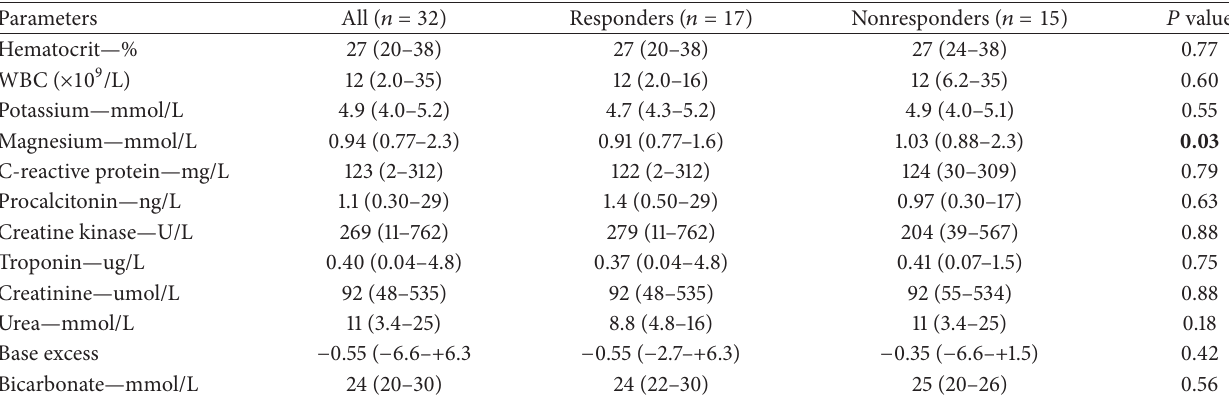
Table 2: Laboratory values prior to